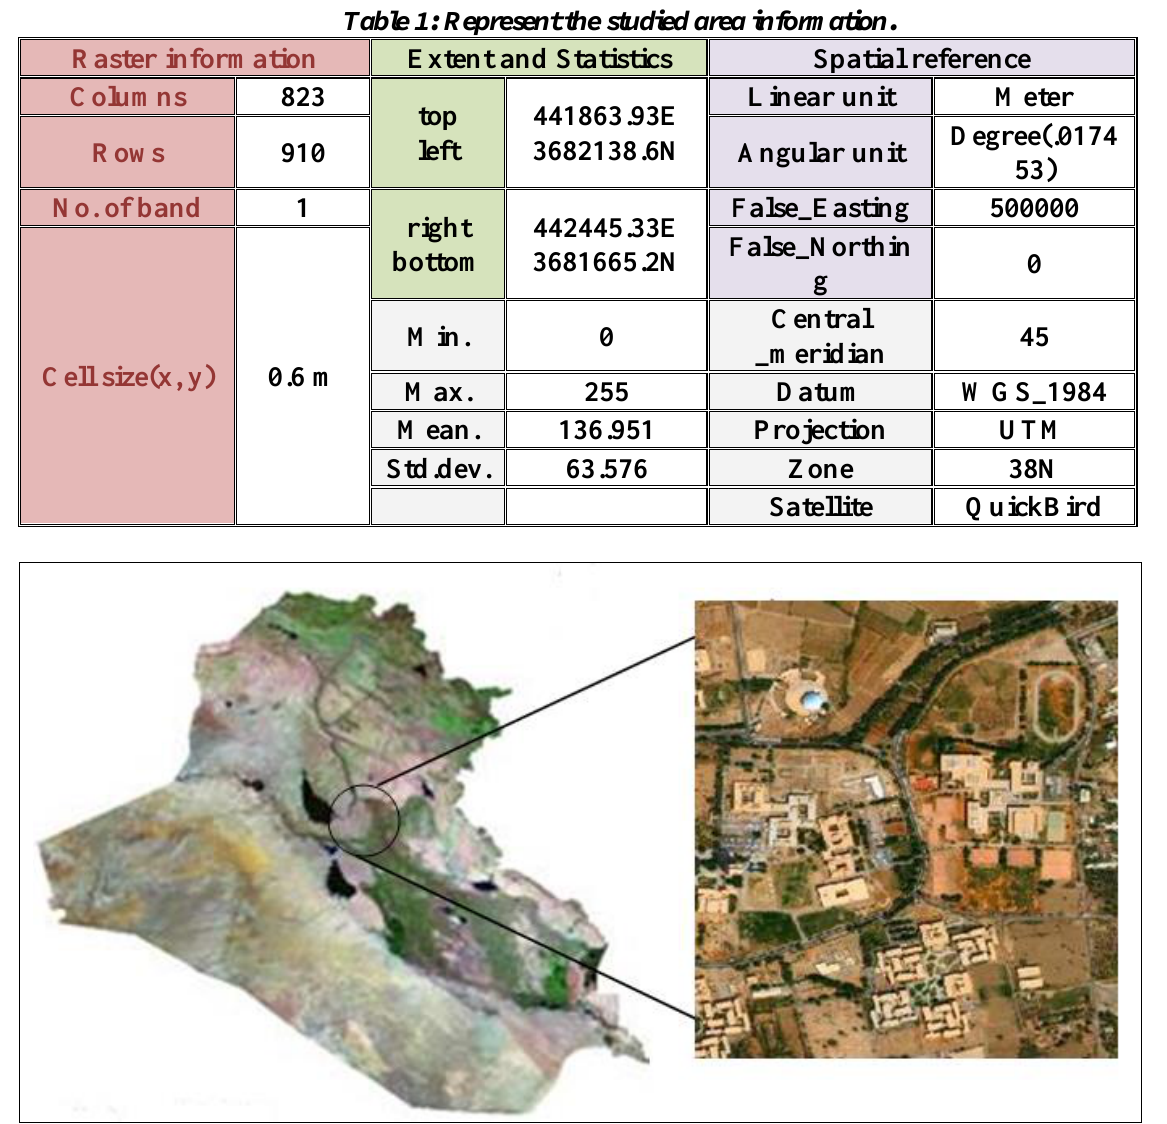
Fig. 2: shows the image of the studied